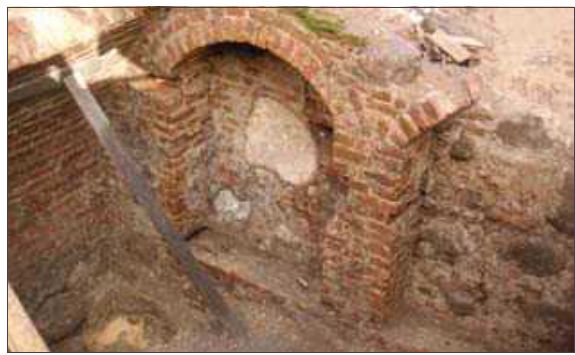
3 pav. 2008 m. atrastas XVI a. antrosios pusės rūsio fragmentas (Šv. Mikalojaus/Pranciškonų g. (Zilinskas, r­.)) Fig. 3. Fragment of cellar of second half of 16th century st Mikalojus/Pranciškonai st (Zilinskas, r­)